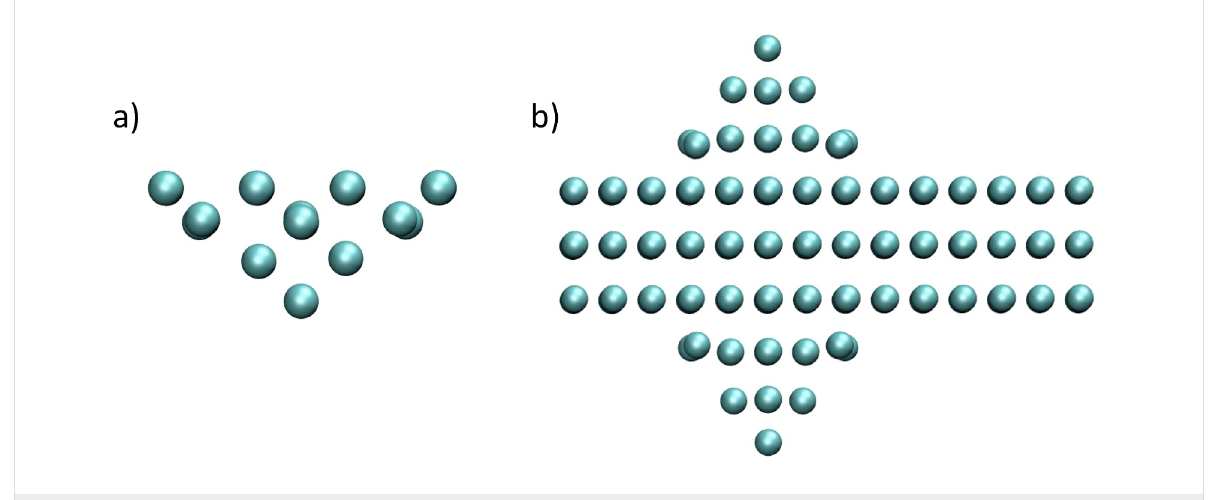
Figure 1: (a) Side-on view of the structure of the Cr and W cluster tip models. (b) The structure of the periodic Cr tip model.